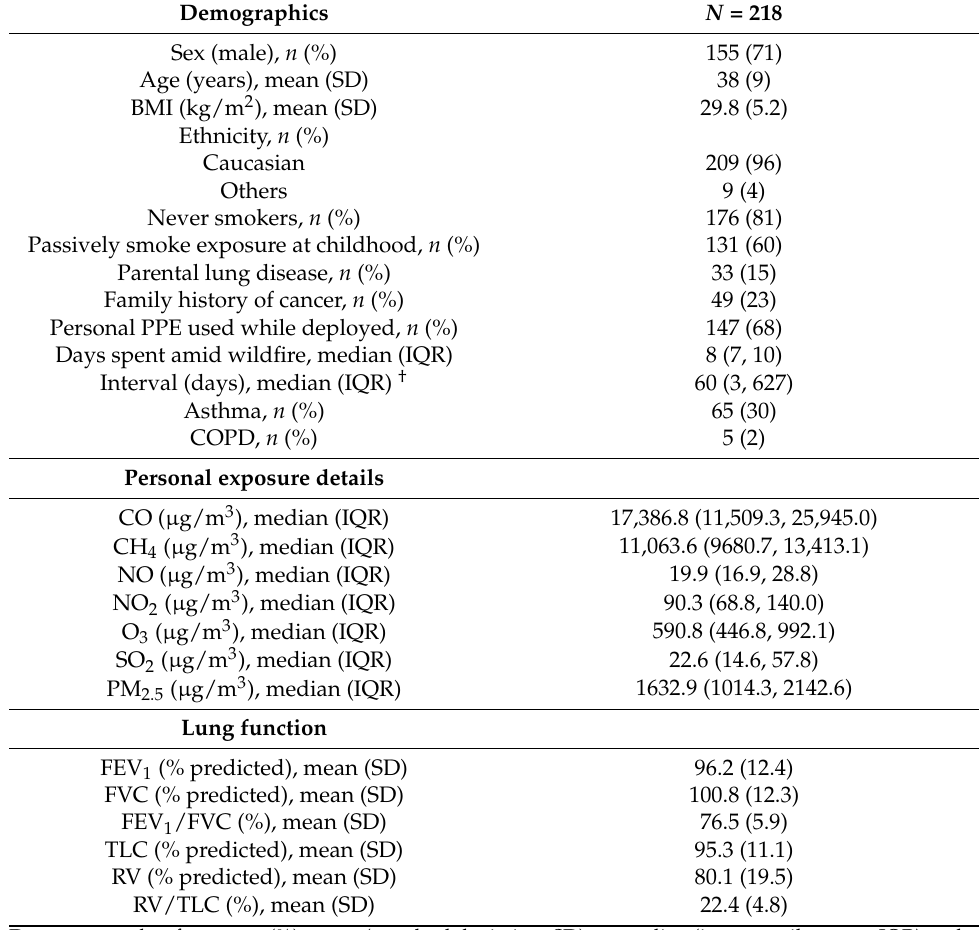
Table 1. Demographic characteristics, exposure history, and clinical profiles of the RCMP